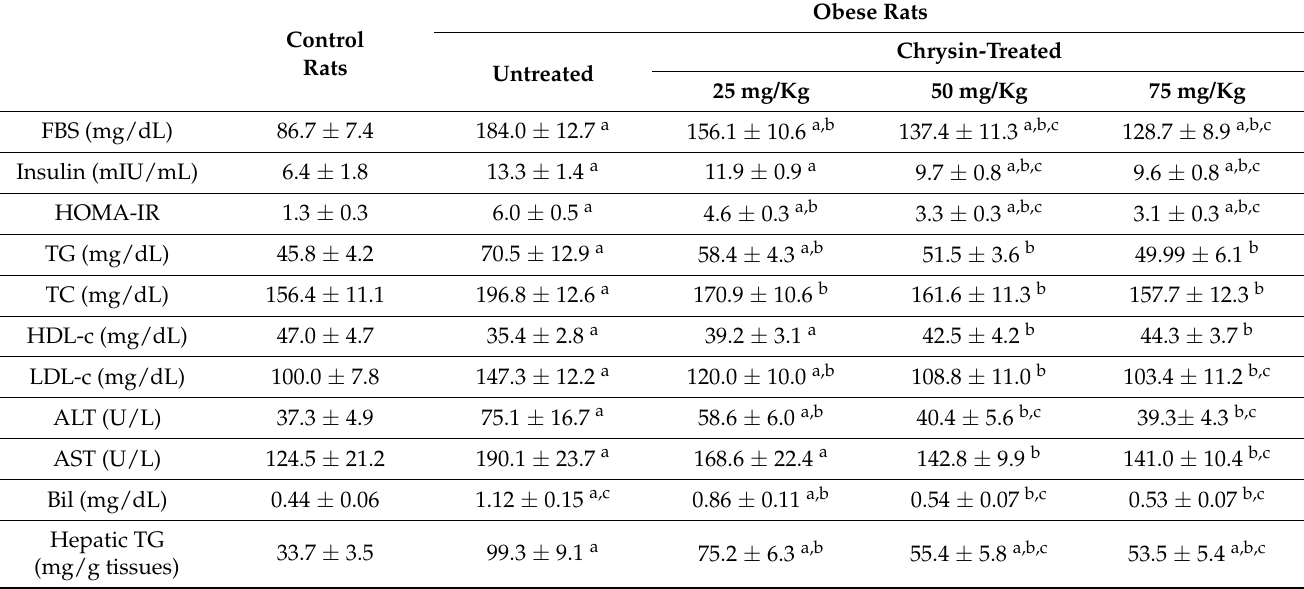
Table 2. Glucose homeostasis parameters, lipid profile, liver function tests in control rats, obese untreated rates, and obese rats treated with different doses of chrysin.